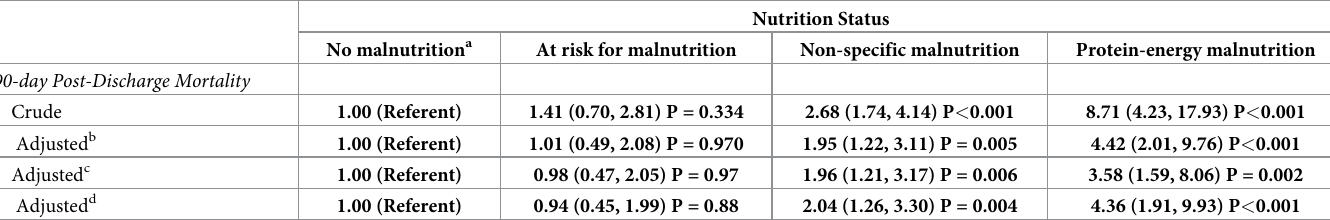
Table 3. Unadjusted and adjusted associations between nutrition status and 90-day post-discharge mortality (n =